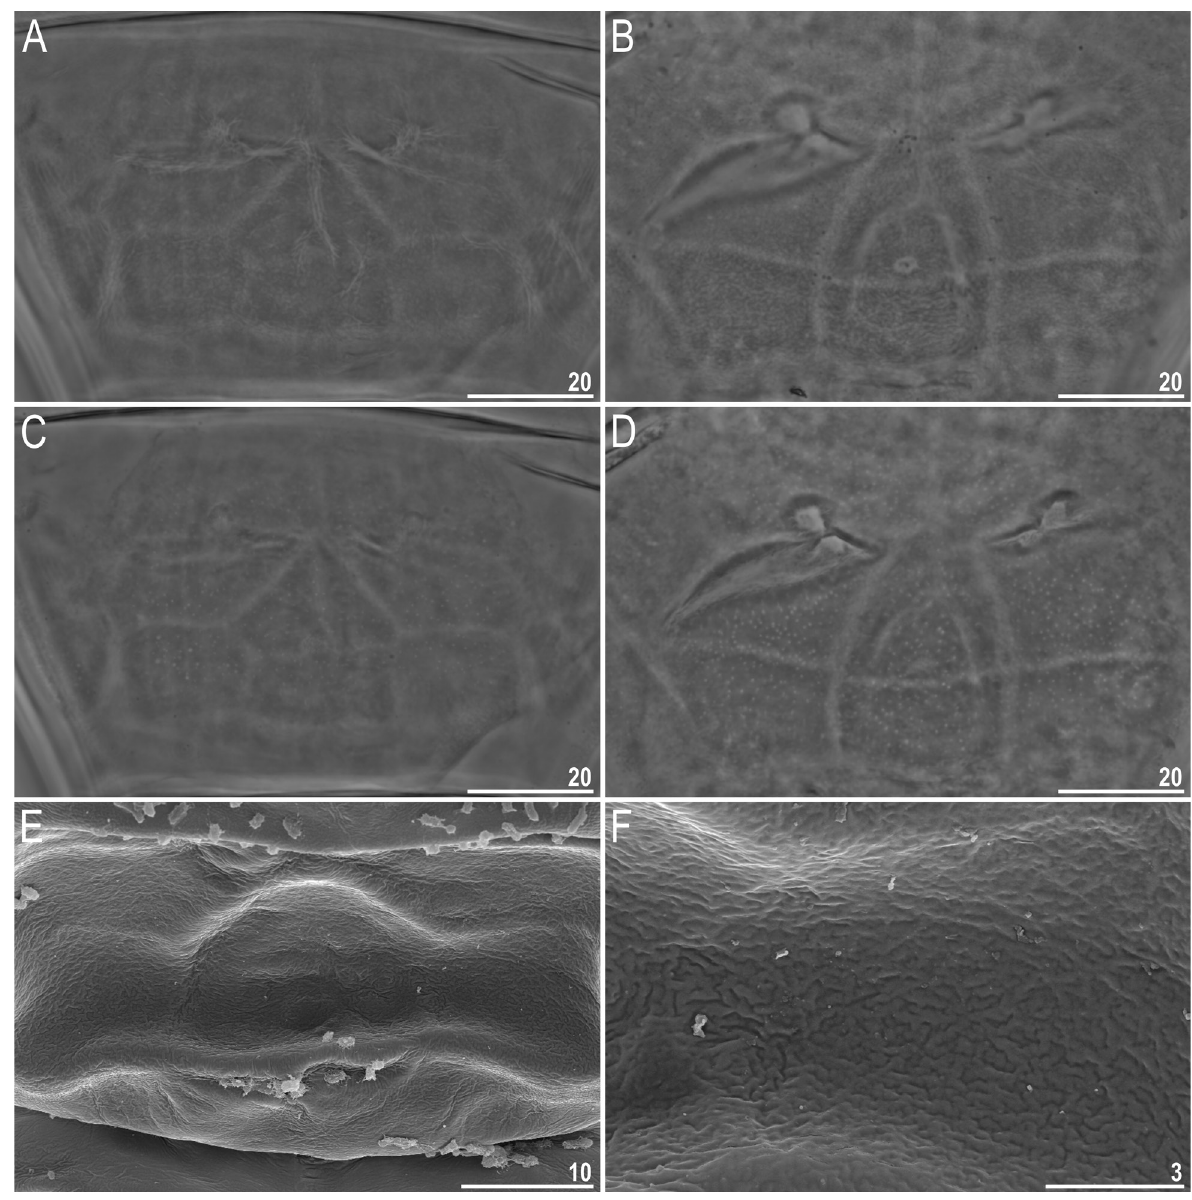
Figure 3. The morphology of Milnesium almatyense Tumanov, 2006 adults cuticle. A Sculptured dorsal cuticle, with visible pseudoplates, specimen from KZ.003 population, PCM; B Sculptured dorsal cuticle, with visible pseudoplates, paratype, PCM; C Dorsal cuticle with visible pseudopores, the same specimens on A from KZ.003 population, PCM; D Dorsal cuticle with visible pseudopores, paratype, PCM. E SEM photograph of dorsal cuticle with visible sculpture and caudal, complex pseudoplate. F SEM photograph of details of sculpture of the dorsal cuticle. The photographs A and C , as well as B and D depict the same specimen and paratype, respectively. All the scale bars are given in